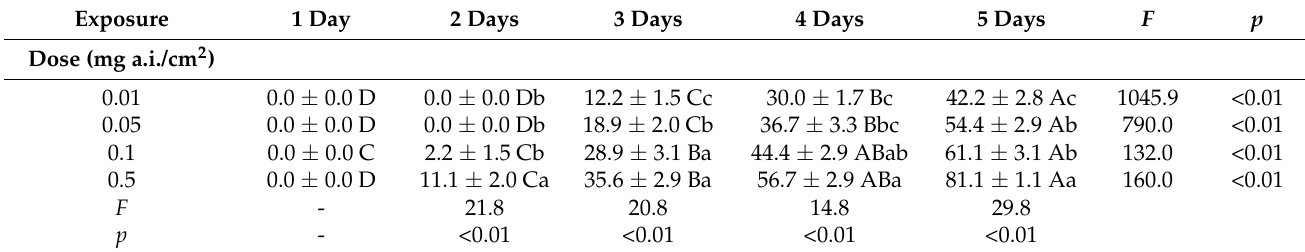
Table 2. Mean immediate mortality (% ± SE) of Tribolium castaneum adults exposed on concrete treated with chlorantranilip- role at four doses (0.01, 0.05, 0.1, and 0.5 mg a.i./cm 2 ), for 1, 2, 3, 4, and 5 days. Within each row, means followed by the same uppercase letter are not significantly different (in all cases DF = 4, 44, Tukey–Kramer HSD test at p = 0.05). Within each column, means that are followed by the same lower-case letter are not significantly different (in all cases DF = 3, 35, Tukey–Kramer HSD test at p = 0.05). Where no letters exist, no significant differences were recorded. Where dashes exist, no analysis was performed.